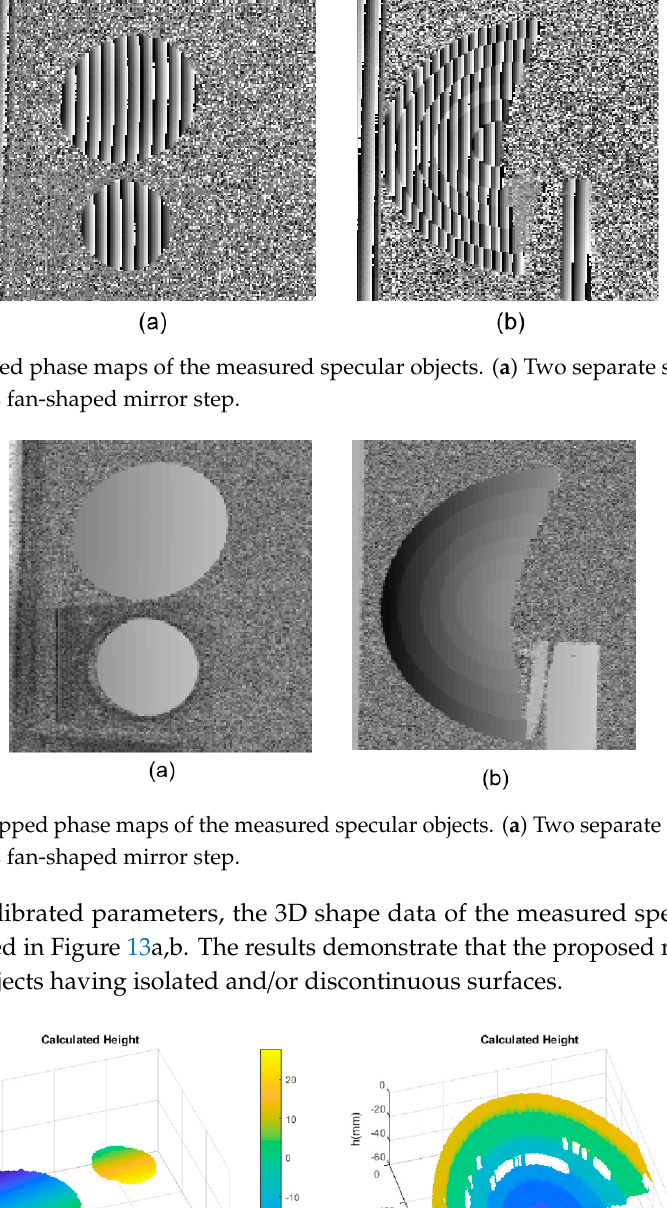
Figure 10. Captured fringe patterns of the measured specular objects. ( a ) Two separate specular objects; ( b ) Discontinuous fan-shaped mirror step.